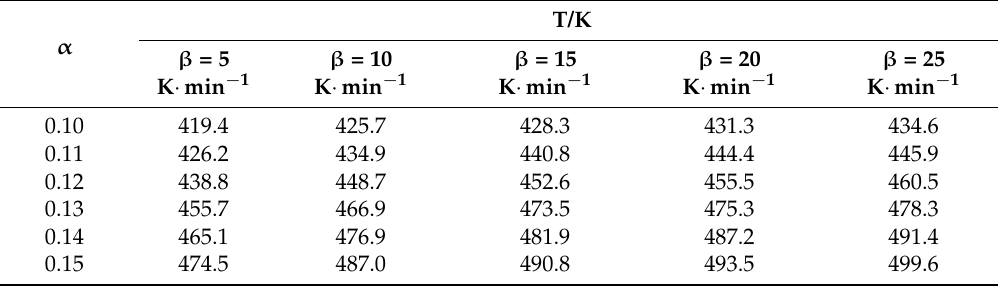
Table 3. Temperatures at the same degree of conversion at different heating